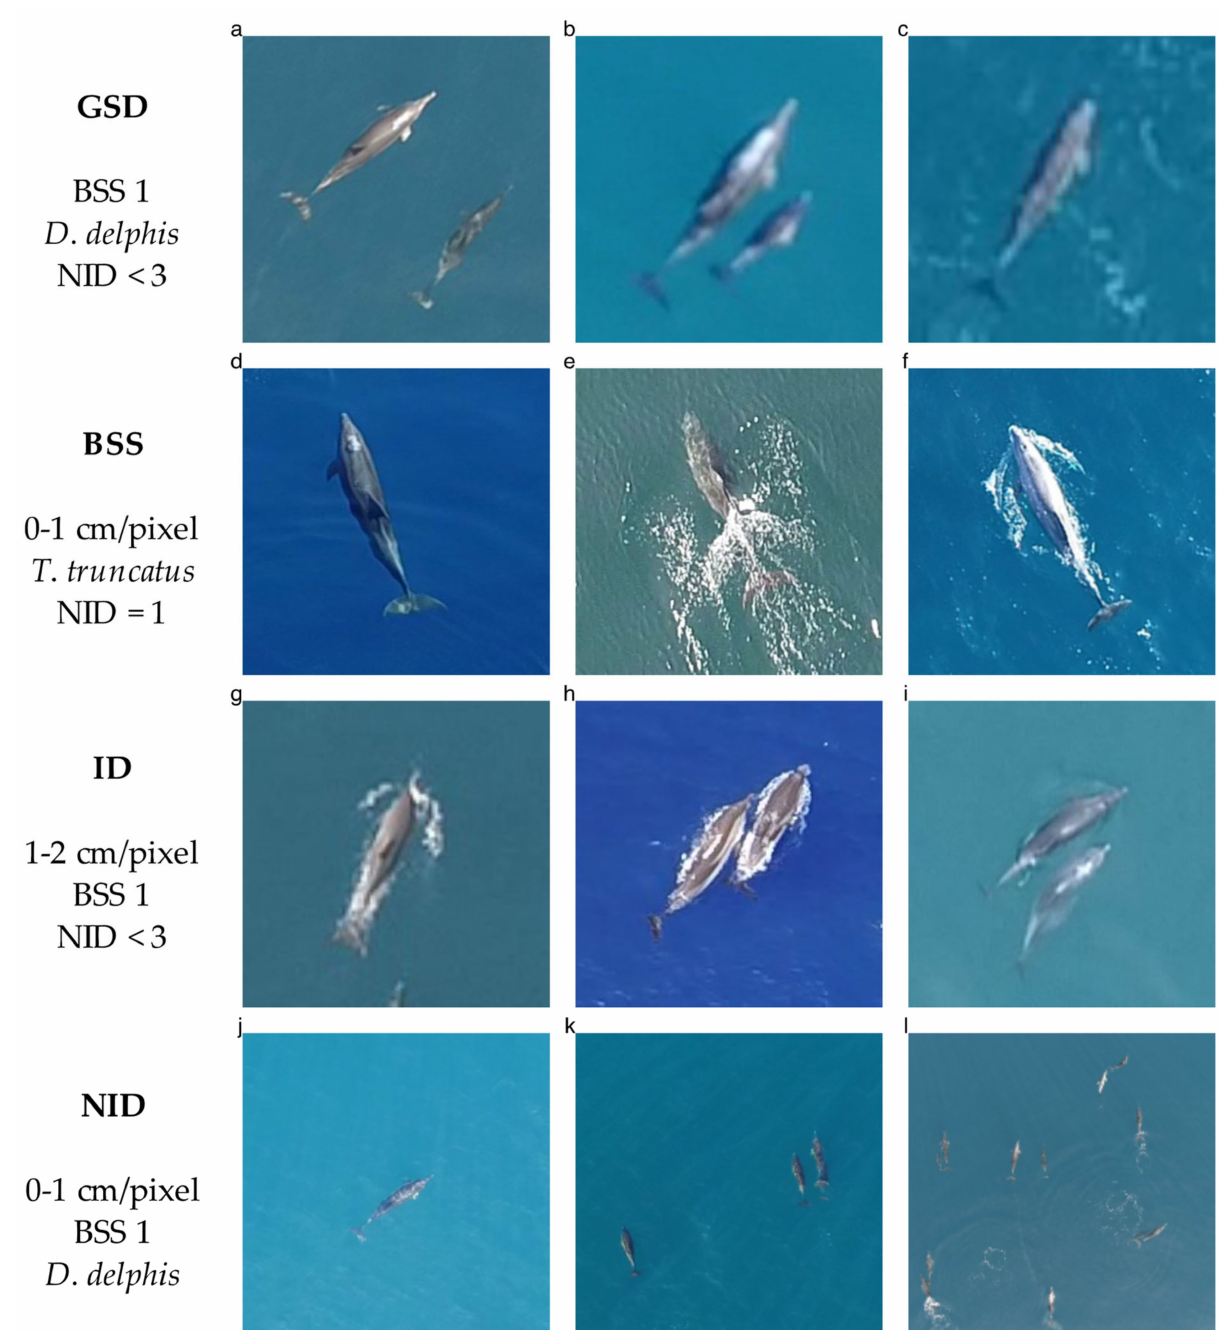
Figure 1. Example effects of image attributes on species identifiability. Each row represents a different variable ( top to bottom: Ground sample distance, GSD; Beaufort sea state, BSS; true species identity, ID; number of individual dolphins, NID) where all other attributes are constant. The columns represent three different levels of each variable: ( a – c ) 0–1 cm/pixel, 1–2 cm/pixel, 2–3 cm/pixel; ( d – f ) BSS-0, BSS-1, BSS-2; ( g – i ) Delphinus delphis , Stenella coeruleoalba , Tursiops truncatus ; ( j – l ) Single animal, small group, large group. All images were resized and cropped for illustration